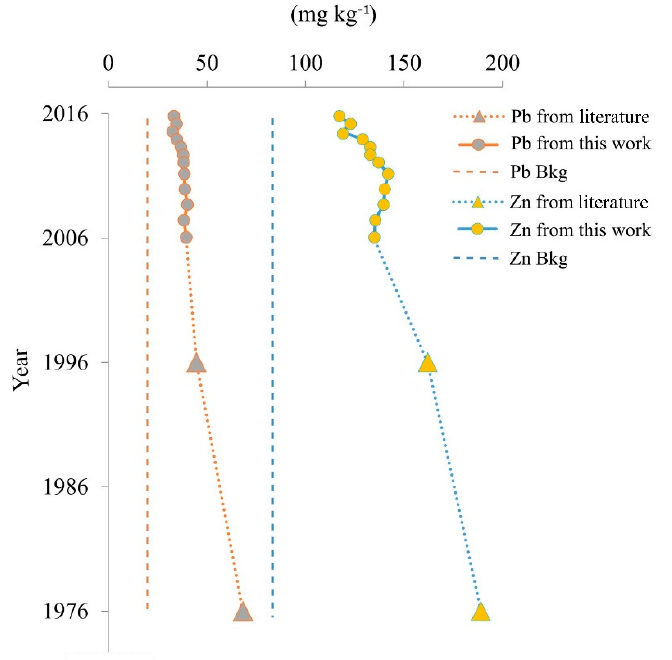
Figure A1. Pb and Zn historical concentration trends. Data from the literature [59,60] and this work (see Table 2).